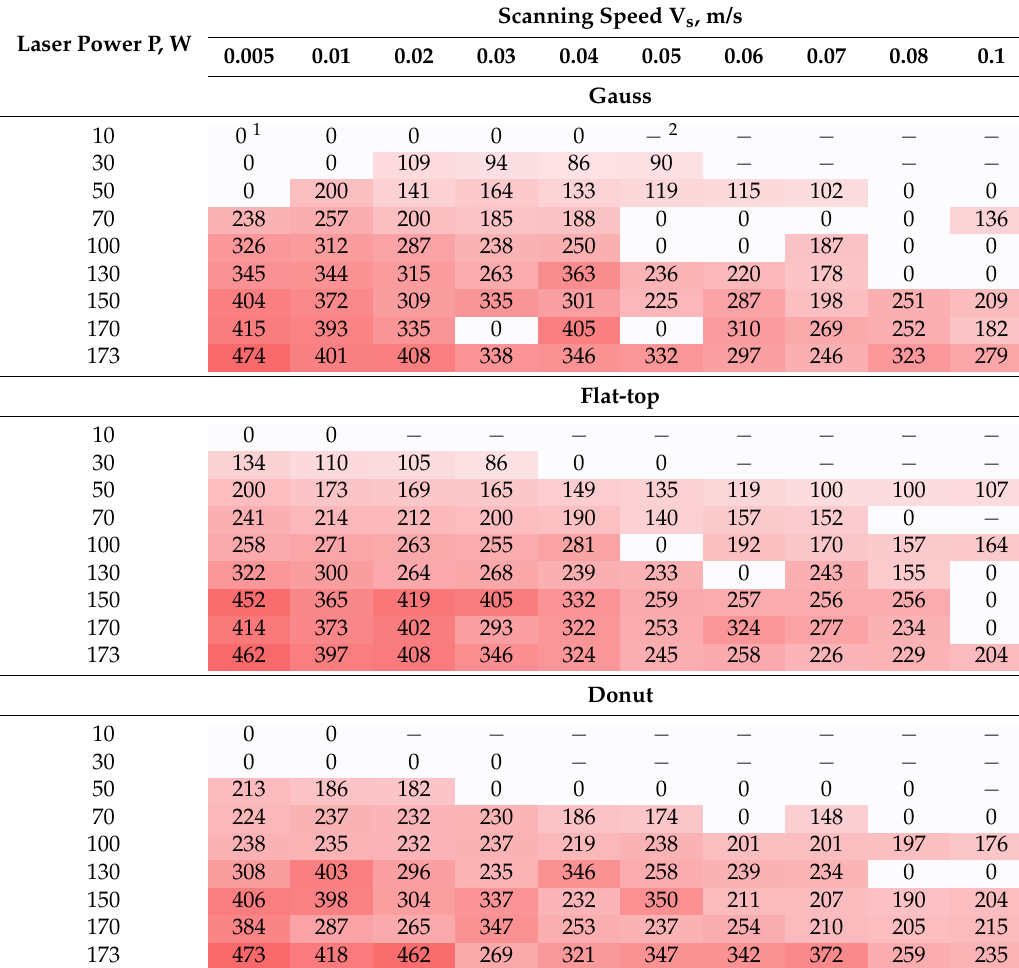
Table 3. Average measured values of single-track width W ( µ m) on process parameters for CoCrMo (the values are colored in grades of red for comparative evaluation of single-track width, where red is for the maximum value and white is for an absence of metallurgical contact or experimental